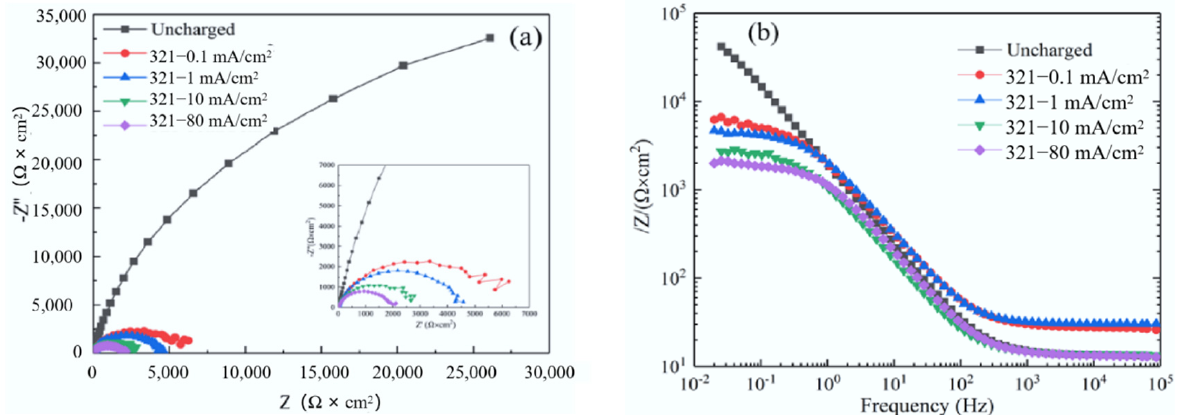
Figure 4. ( a ) Nyquist plots for different hydrogen charging current densities regarding the proposed test condition and ( b ) corresponding impedance results.